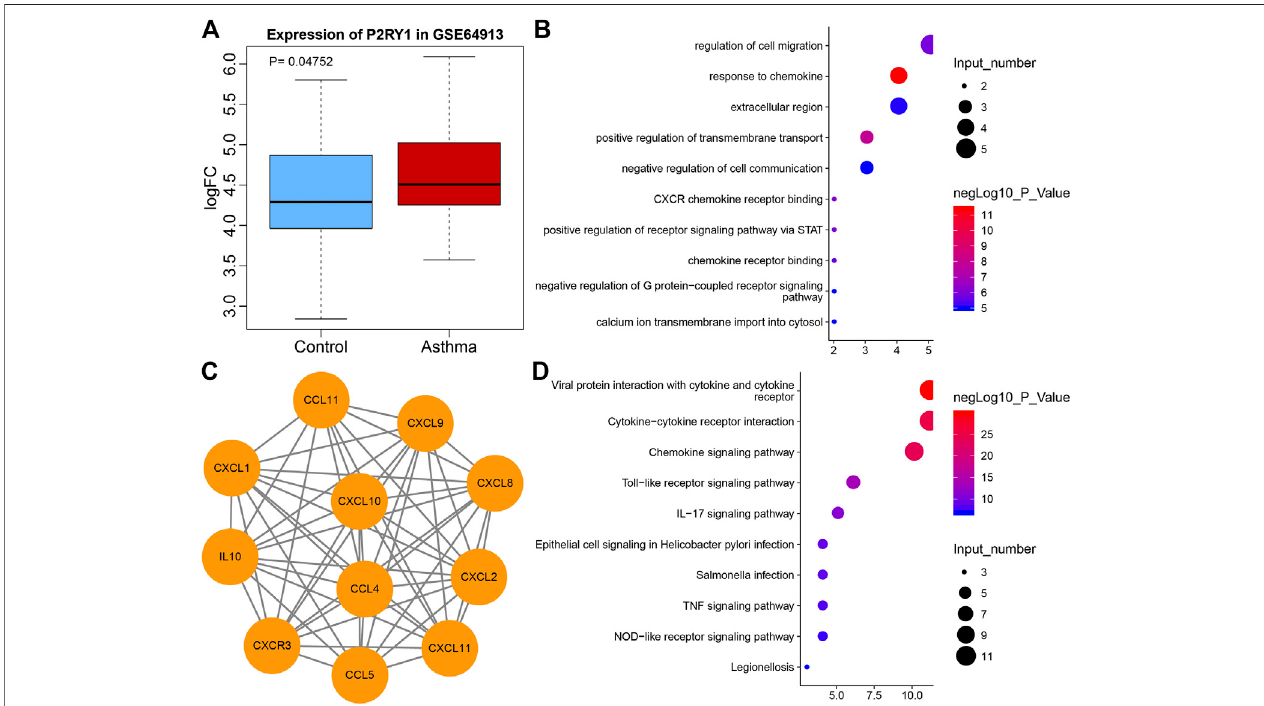
FIGURE 1 | The potential signi fi cance of P2Y1 and CXCL10 in asthma. (A) Box plot of P2Y1 expression in normal samples (blue) and asthma samples (red) in microarrayGSE64913. (B) 10genesthatinteractedwithCXCL10predictedbyString. (C) TheGOenrichmentmapofCXCL10and10interactiongenes.Theverticalaxis represents the enriched entry, and the horizontal axis represents the number of genes enriched in the entry. The color of the bubble as shown by the color scale on the right indicates the enrichment signi fi cance in the entry. (D) The KEGG enrichment map of CXCL10 and 10 interaction genes, the vertical axis represents the enriched item, the horizontal axis represents thenumber of genes enriched in the item, and the colorofthe bubble indicates theenrichment signi fi cance asshown in the color scale on the right.